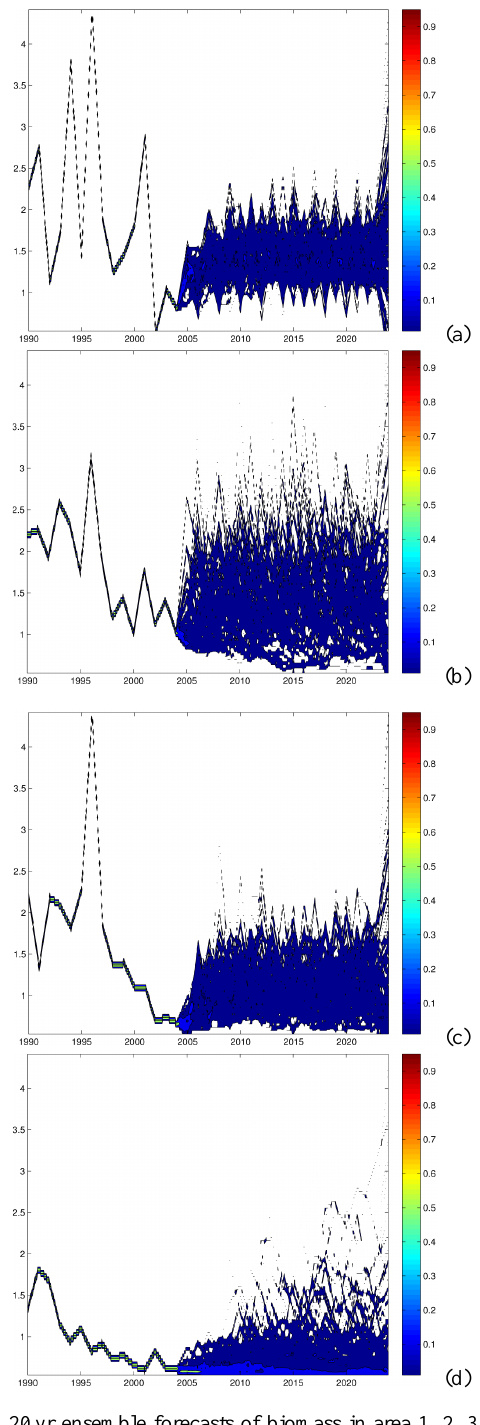
Fig. 5. 20yr ensemble forecasts of biomass in area 1, 2, 3, and 4 following reanalysis run 1990–2004. The ensemble averages over climatic variability as represented by T , by drawing deviates as de- scribed in Sect. 3.1: (a) WGNSSK area 1, (b) WGNSSK area 2, (c) WGNSSK area 3, (d) WGNSSK area